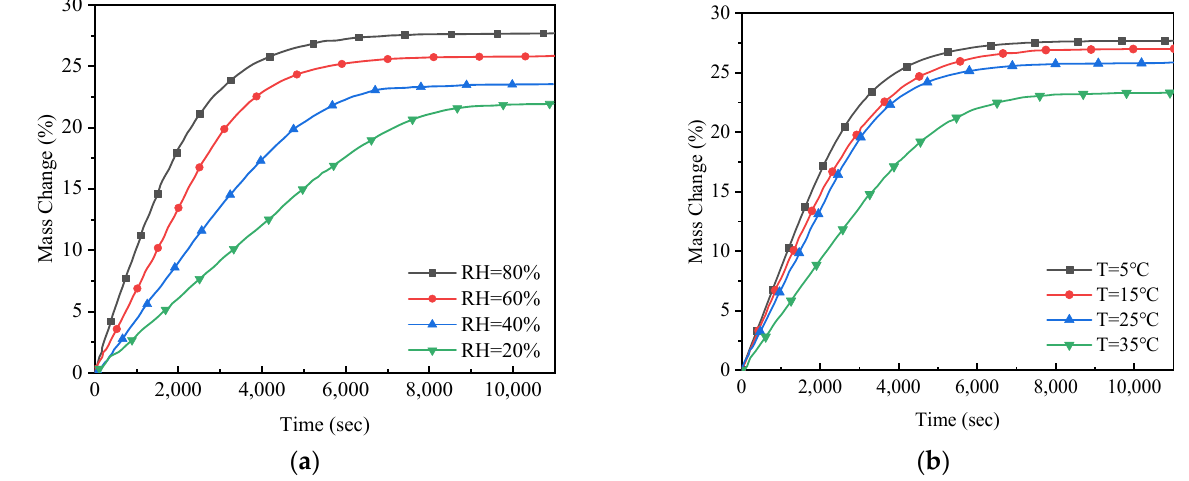
Figure 6. Adsorption curve of MOF-801 at different humidity and temperature. ( a ) Adsorption curve of MOF-801 at T = 25 °C and different humidity. ( b ) Adsorption curve of MOF-801 at RH = 60% and different temperatures.